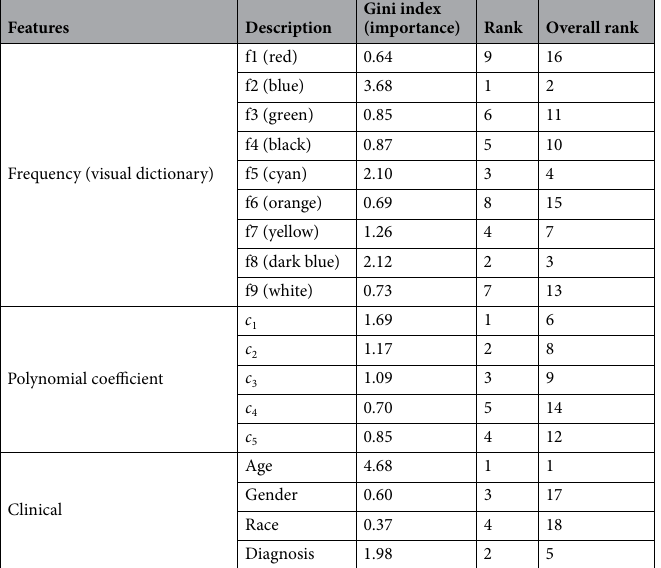
Table 3. Ranking of the important features for the dichotomized level of kidney function at the biopsy. c n : polynomial coefficients in Eq. (1).